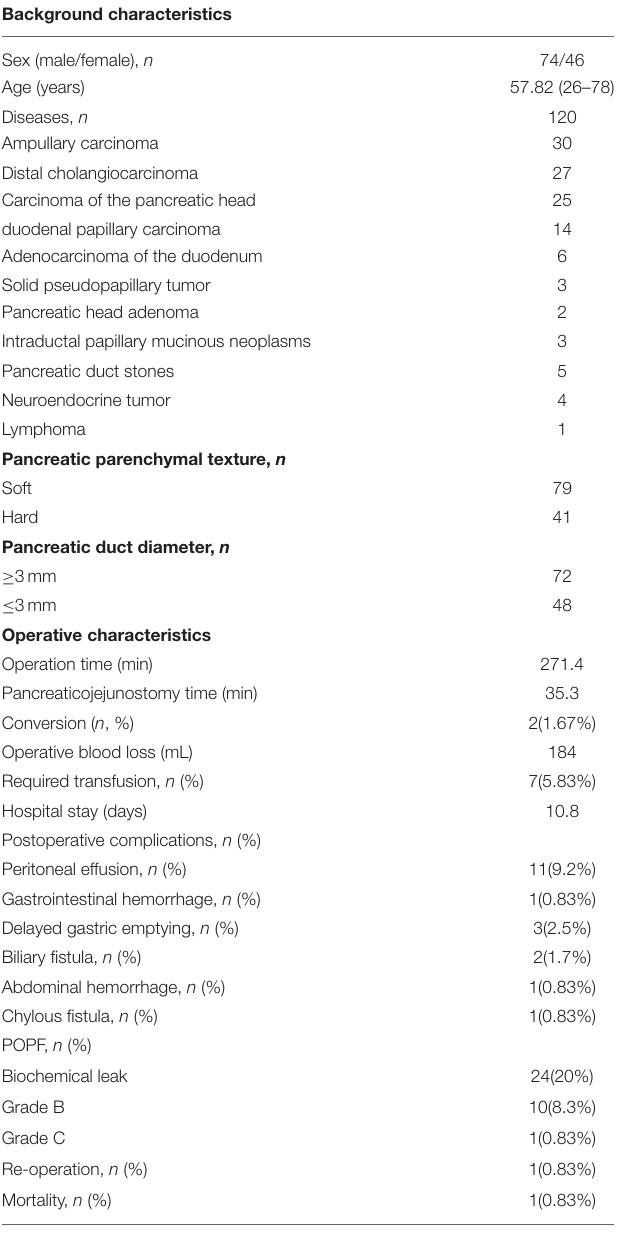
TABLE 1 | Demographics, operative characteristics and postoperative complications in 120 patients. Background